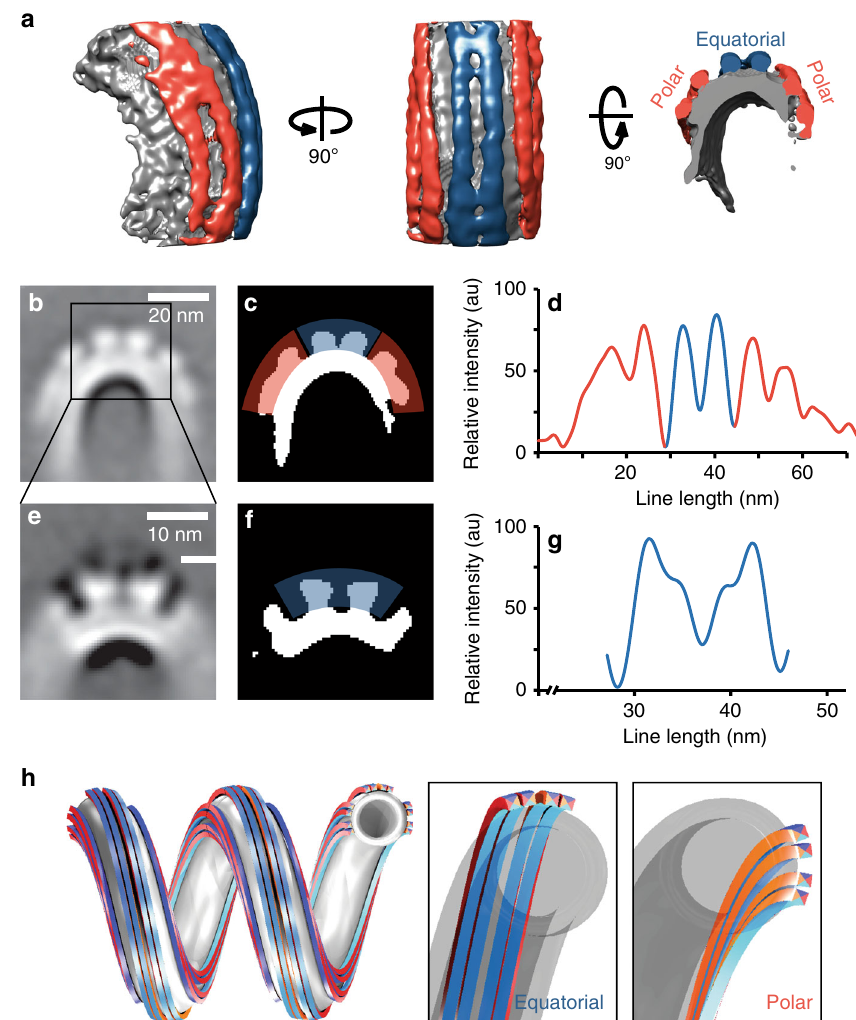
Fig. 2 ESCRT-III fi lament bundles form distinct clusters on the surface of helical tubes. a Side view (left), top view (center) and cross-section (right) of a global subtomogram average showing fi laments following the tube axis, in the equatorial (blue) and polar (red) binding mode, respectively. b Sum projection of a central segment of the tube in a showing fi laments on the outer surface of the helical tube, organized as one equatorial and two polar clusters. Scale bar 20 nm. c Equatorial (blue) and polar (red) fi lament cluster highlighted on the thresholded image b . d Intensity pro fi le of protein density in c . e Projection of the re fi ned map of the equatorial cluster showing that both fi laments of the cluster are made of two strands each. Scale bar 10 nm. f Thresholded image of e . g Intensity pro fi le of protein density in e . For fi lament dimensions, see Supplementary Table 1. h 3D model of one equatorial and two polar fi lament bundles, each formed from two double-strands, on a helical membrane tube (gray). All fi laments are identical, except that equatorial and polar fi laments bind the membrane through the cyan and orange interfaces, respectively (insets). Filaments in the two hemispheres are shown as antiparallel. Source data are provided as a Source Data fi